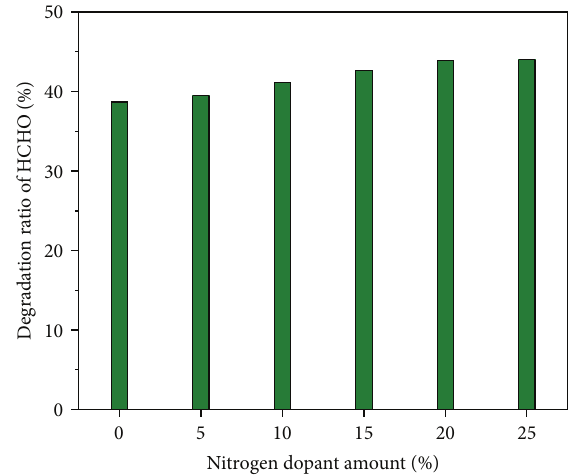
Figure 6: Effect of nitrogen doping amount on photocatalytic activ- ity of N-doped TiO 2 .